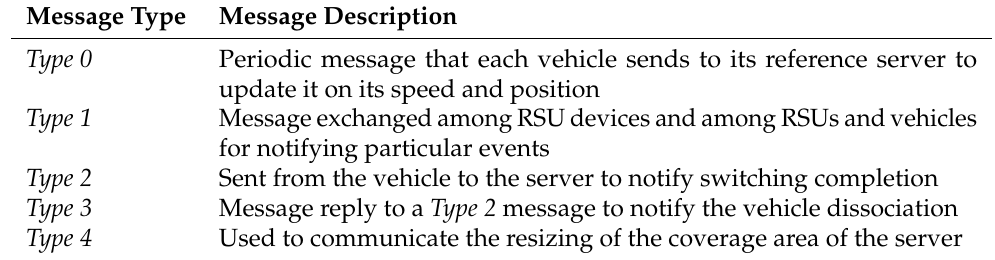
Table 2. Messages